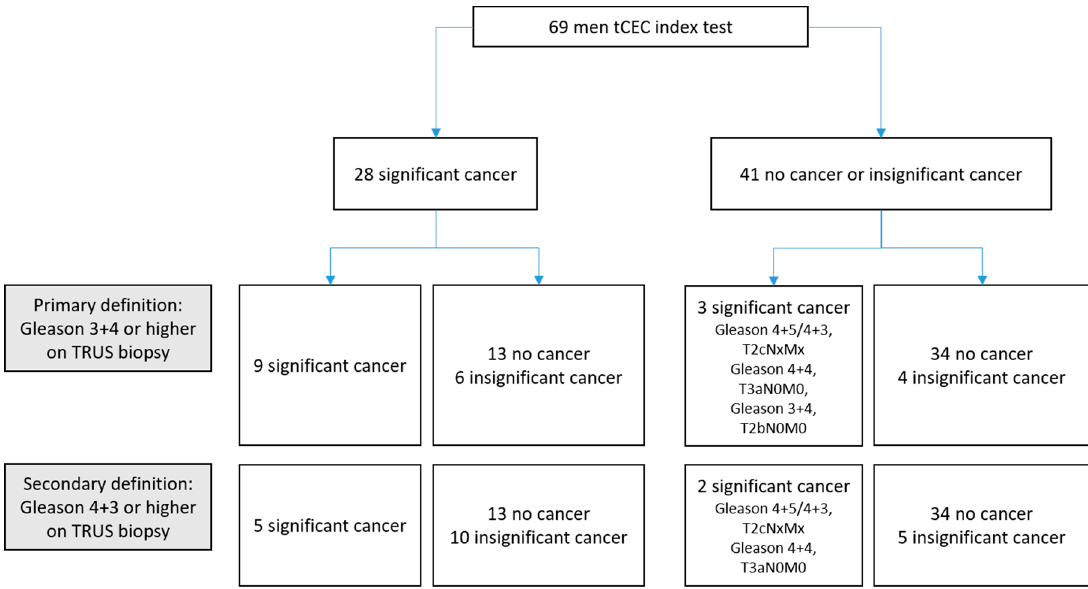
Figure 3. Diagnostic accuracy of the tCEC test for detection of clinically significant cancer in men with PSA readings <10 ng/mL on TRUS biopsy. tCEC: tumour-associated circulating endothelial cells, TRUS biopsy: transrectal ultrasound-guided biopsy. Primary definition: Sensitivity 75% (95% confidence interval (CI) 43–95), specificity 67% (53–79), positive predictive value 32% (16–52),